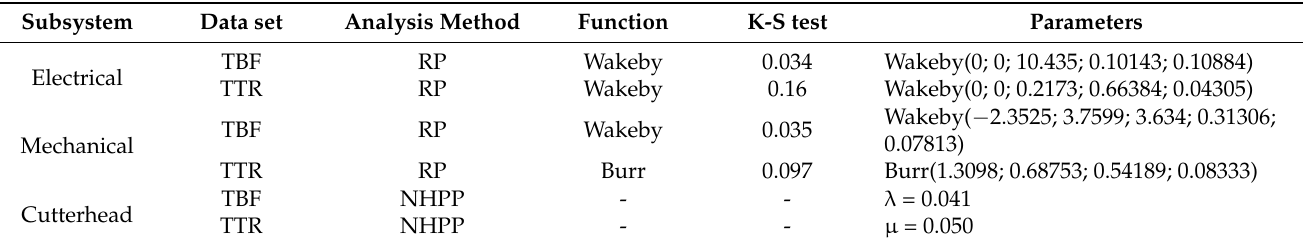
Table 7. Parameters of distributions for the TBFs and TTFs data of subsystems.